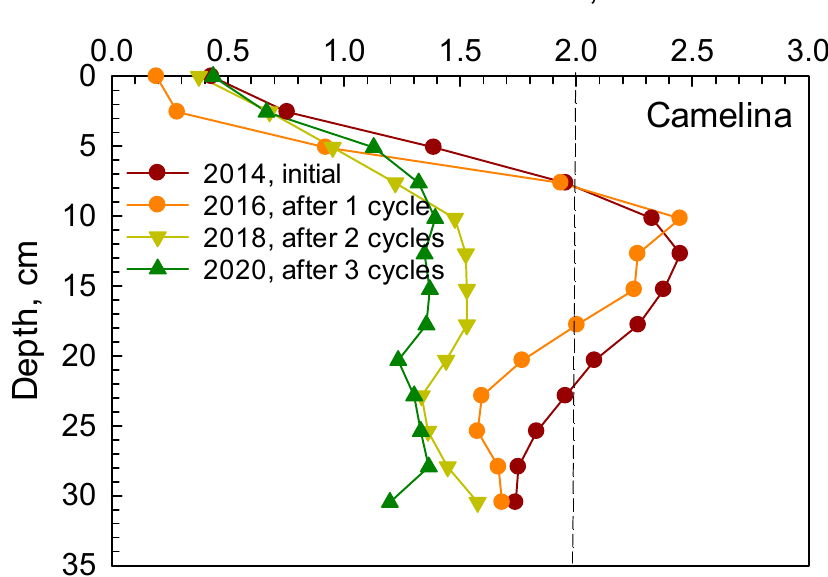
Figure 2. Initial mean soil penetration resistance across all plots in 2014 and after 1 cycle in 2016, after 2 cycles in 2018, and after 3 cycles in 2020 for camelina as a previous crop.